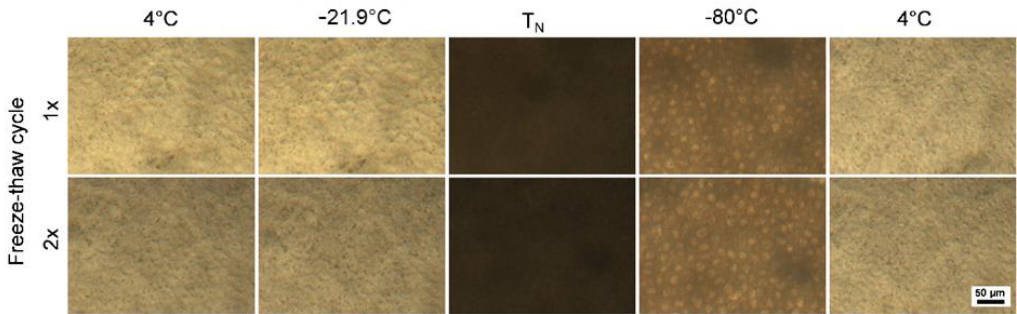
Figure 4. Cryomicroscopic images of the hAM during the first (1×) and second (2×) freeze–thaw cycles. The images represent the appearance of the membrane before freezing (left: 4 °C), directly before ice The images represent the appearance of the membrane before freezing (left: 4 ◦ C), directly before ice formation (−21.9 °C), after ice formation (T N ), at the aimed storage temperature (−80 °C), and after thawing formation ( − 21.9 ◦ C), after ice formation (T N ), at the aimed storage temperature ( − 80 ◦ C), and after (right 4 °C). Scale bar 50 µm. thawing (right 4 ◦ C). Scale bar 50 µ